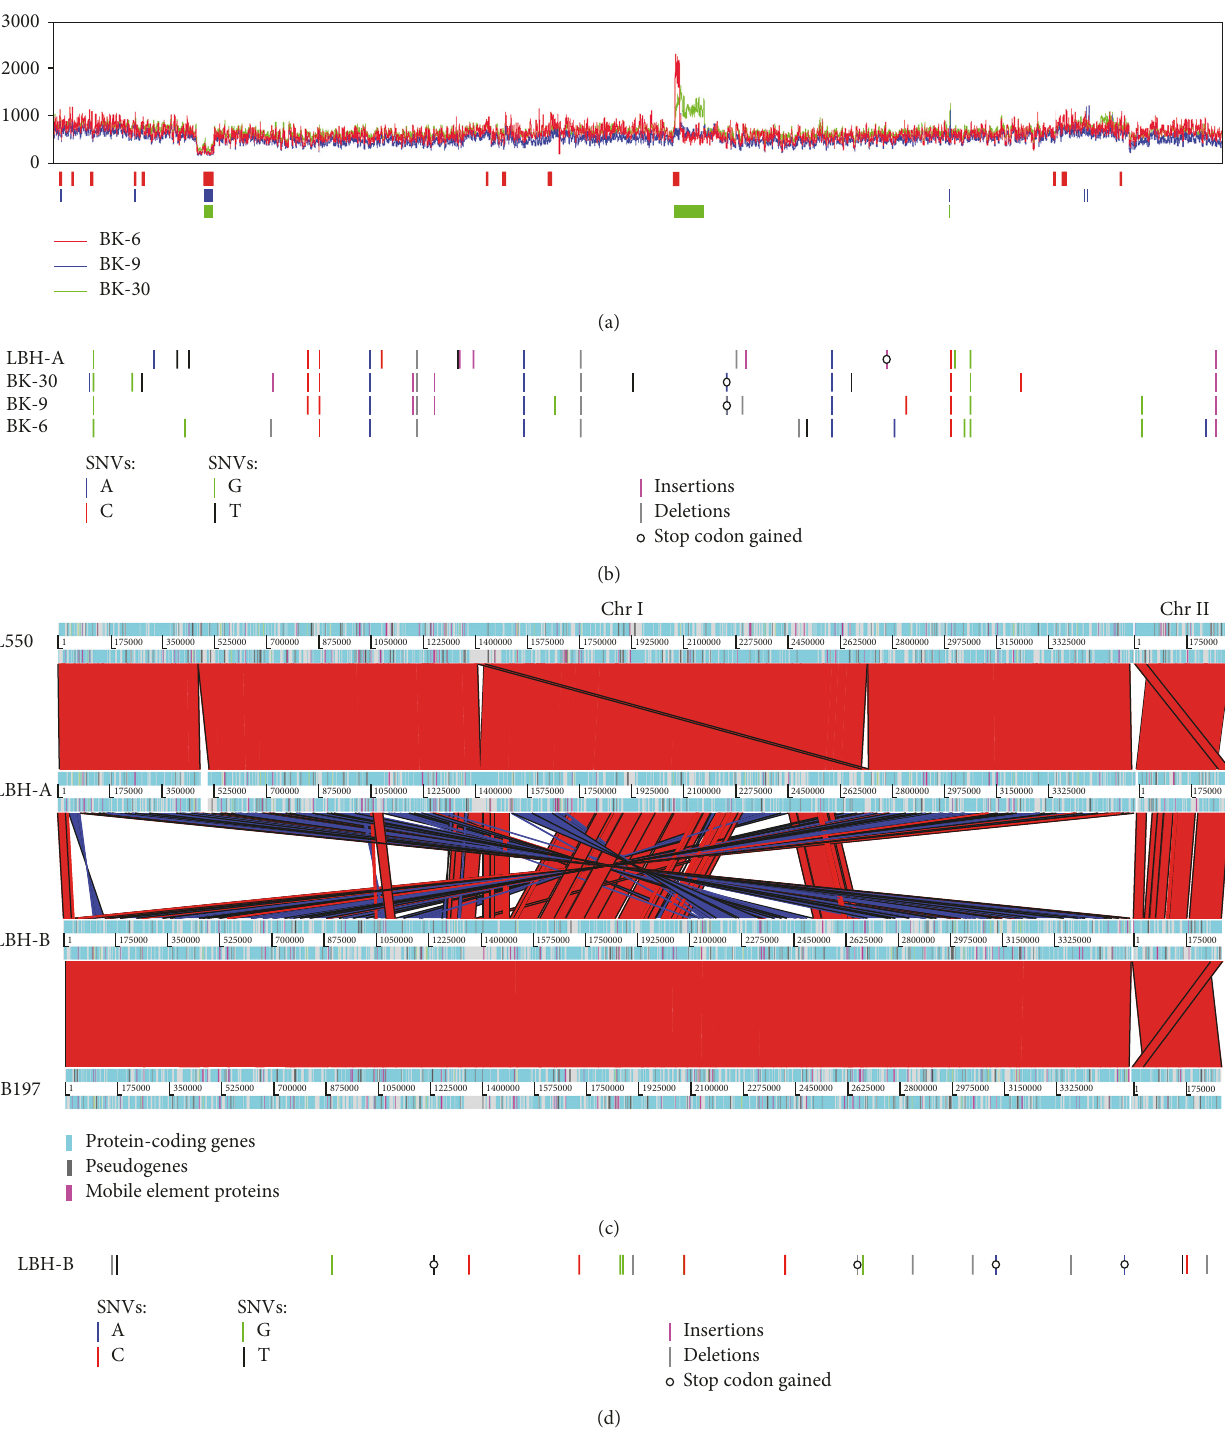
Figure1: Overviewofgenomicvariabilityamongthespecimensincludedinthisstudy .Panel(a)showsvariationsinreaddepthforthealignment of reads from the three field isolates against the chromosomes of L. borgpetersenii strain L550 (subtype A). CNVs (insertions and deletions) larger than 2kb predicted by CNVnator are shown below the plot. Panel (b) shows nonsynonymous SNVs and short indels located within protein-coding genes, identified for the four subtype A specimens by using strain L550 as a reference. Panel (c) shows chromosome-to- chromosome comparisons among the two reference genomes for subtype A and B and the genomes of our corresponding laboratory strains. In these comparisons, red bands indicate similar regions and blue bands indicate inversions. Panel (d) is similar to panel (b) but for variants identified for the subtype B laboratory strain, using the genome of strain JB197 as